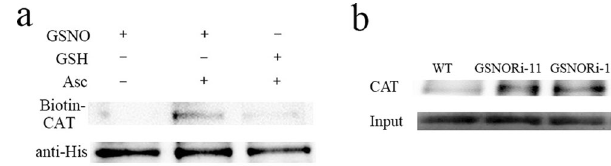
Fig. 5 S-nitrosylation of the CAT protein in vitro and in vivo. a Recombinant CAT was treated with GSH (negative control for GSNO) or GSNO to measure S-nitrosylation by the biotin switch method. Without sodium ascorbate (Asc) sample as another negative control. Protein samples were separated via SDS – PAGE and analyzed by immunoblotting using an anti-biotin antibody and the His tag antibody. b Protein